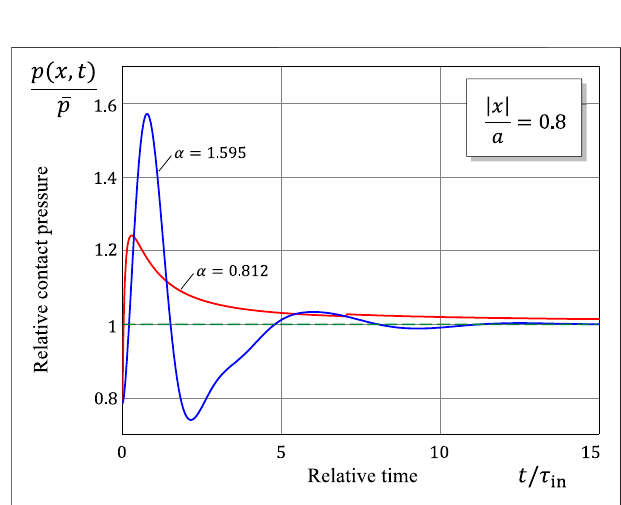
FIGURE 8 | Time-variation of the contact pressure at some point away from the